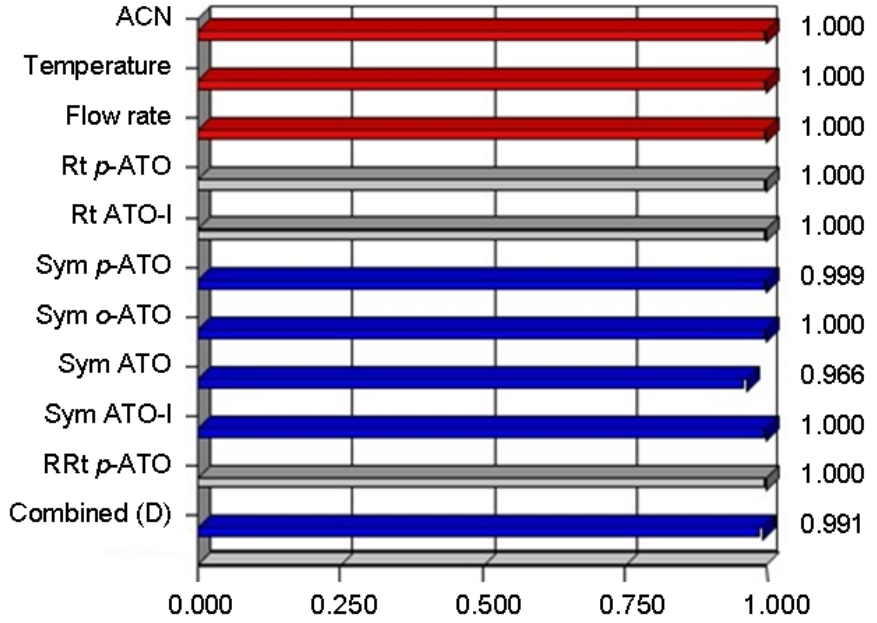
) of various objective responses. i